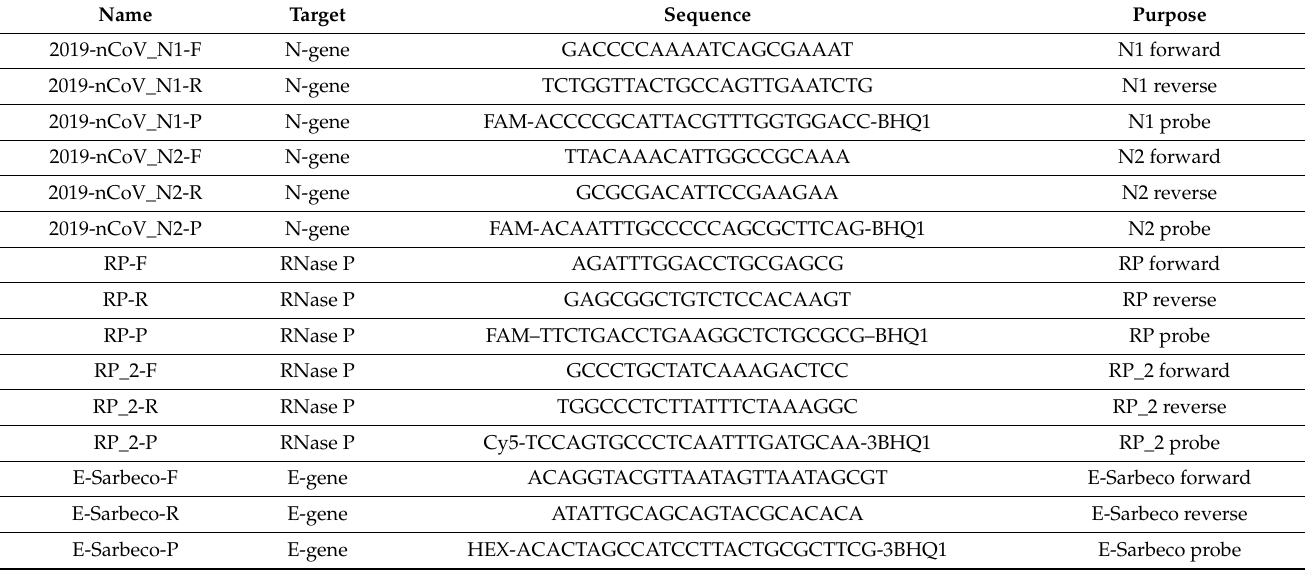
Table 2. Primer/probe sequences used in this